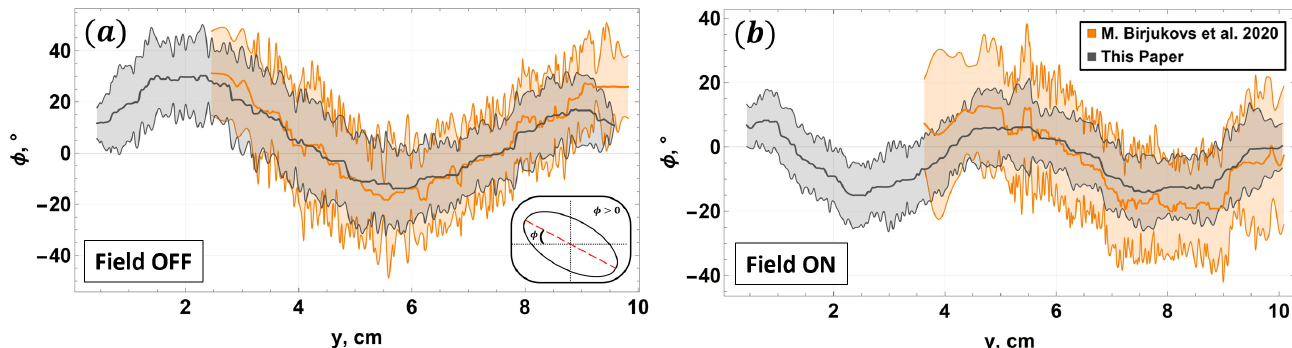
Figure 16. Bubble tilt angle versus elevation (averaged curves and error bands) over the FOV bottom for ( a ) the case with no applied MF (Figure 14a,b) and ( b ) applied horizontal ∼ 265 mT MF (Figure 14c,d), both cases at a 100 sccm flow rate. Orange indicates the previous paper [8] and the current results are shown in gray. The tilt angle definition is shown in the bottom-right corner of ( a